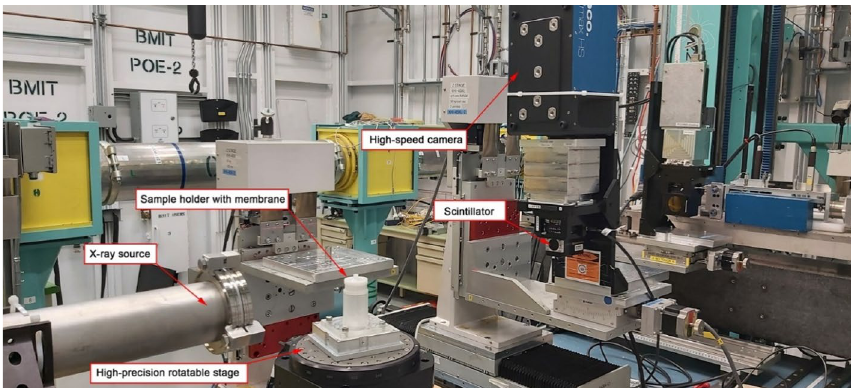
Figure 2. Photo of the experimental SR-μCT system in BMIT hatch at the Canadian Light Source